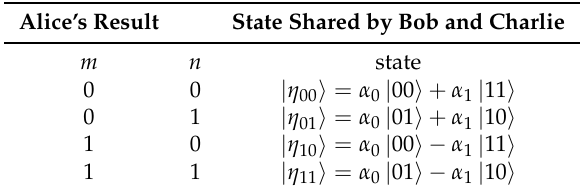
Table 1. Results after Alice’s measurement, labeled by the indexes ( m , n ) , and corresponding states shared by Bob and Charlie. Alice’s Result State Shared by Bob and Charlie m